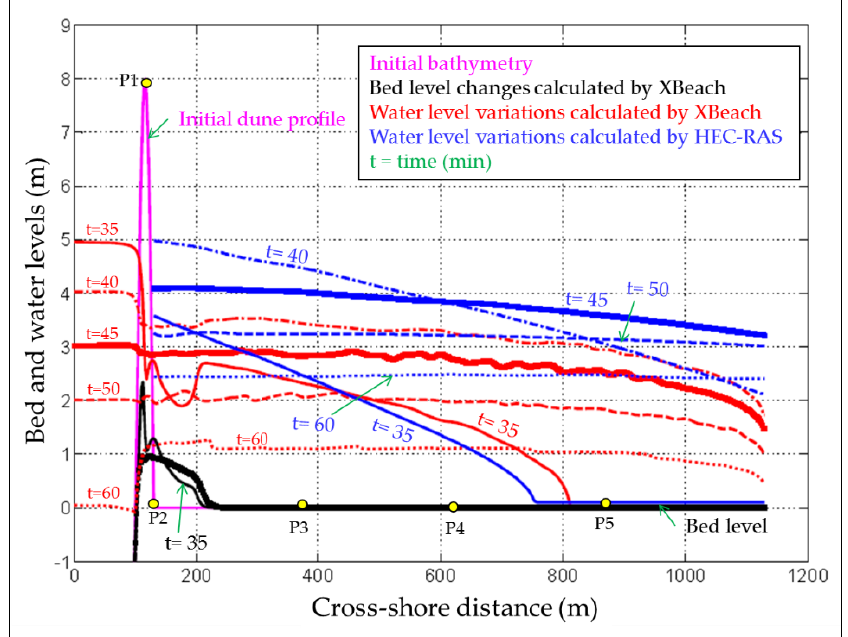
Figure 9. Comparison of water levels calculated by both HEC-RAS and XBeach (1D) at times 35, 40, 45, 50 and 60 min under the triangular load (LC2).